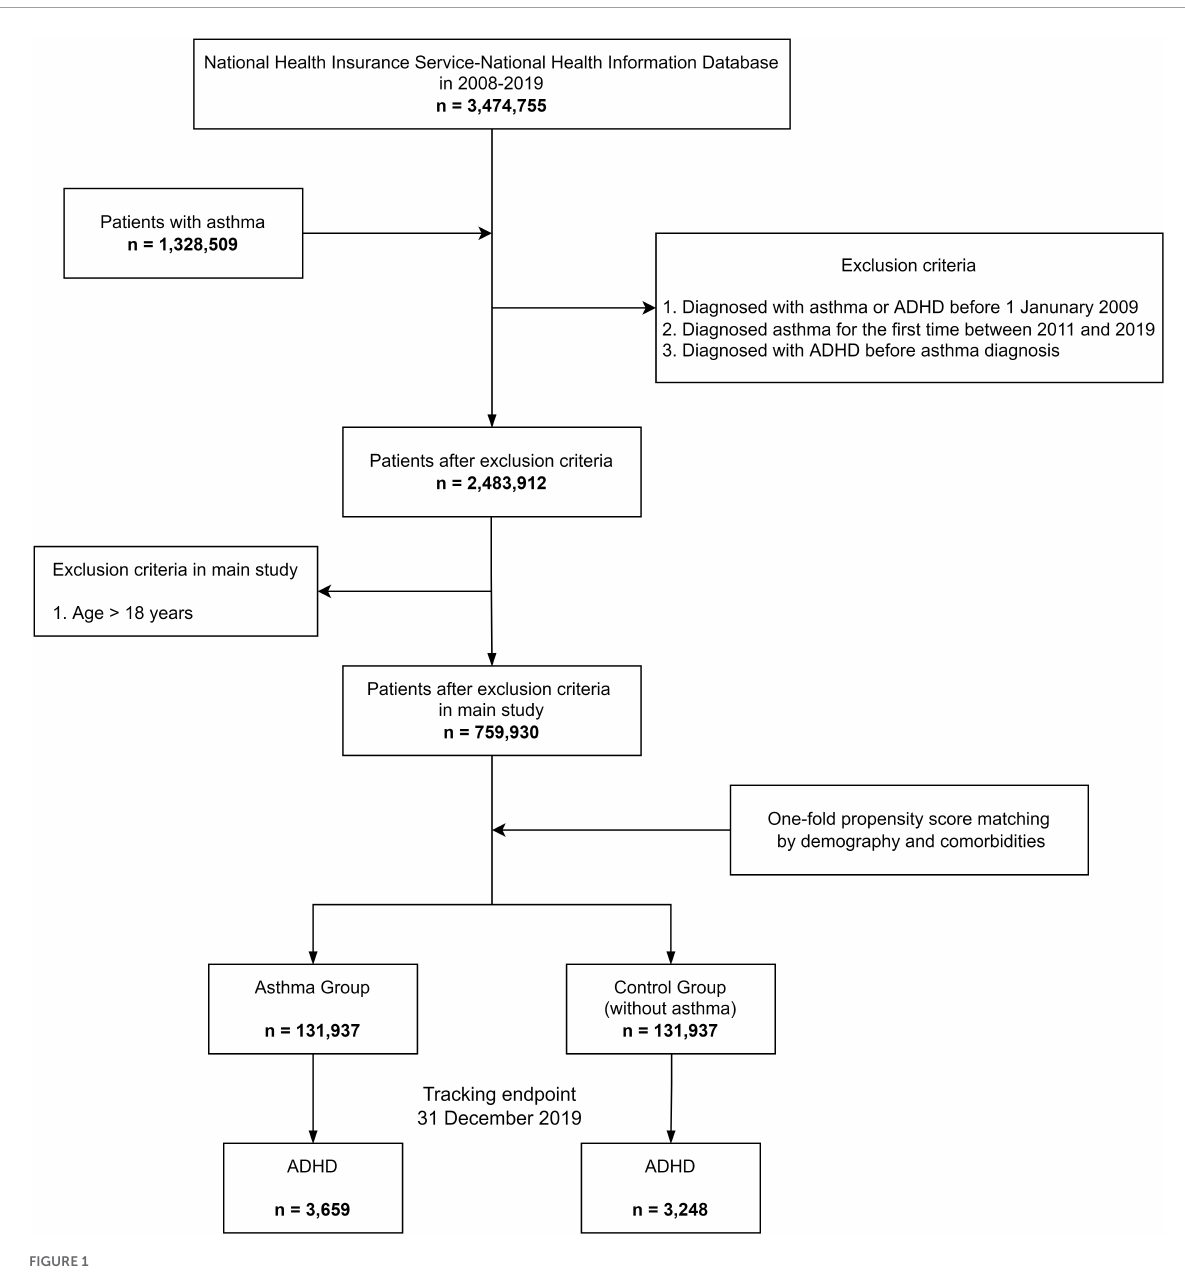
FIGURE1 Study 1. Flow chart for experiment